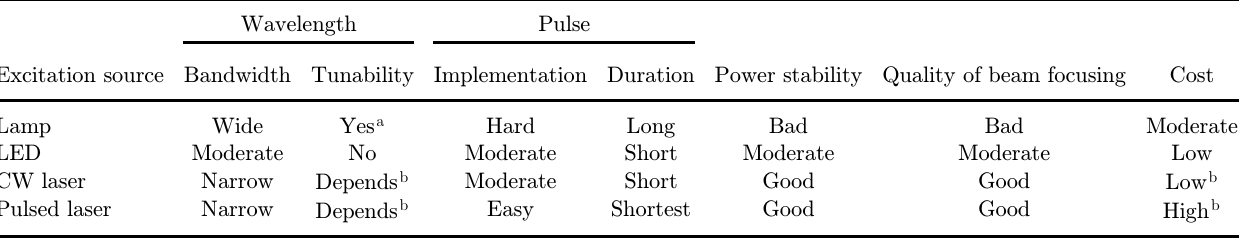
Table 1. Comparison of excitation sources for TG